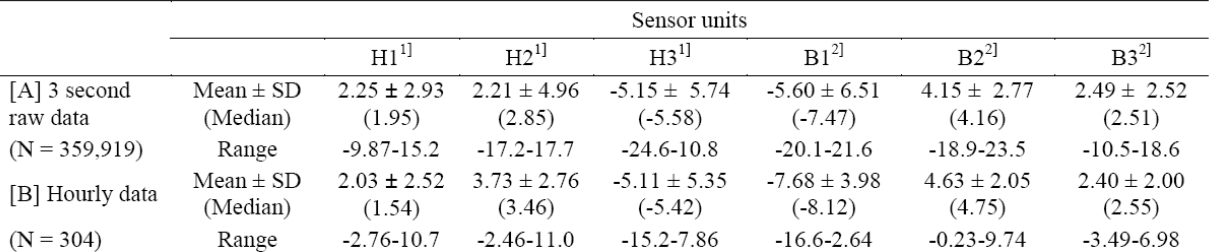
Table 3. A statistical summary of percent deviation (PD) values for each sensor unit calculated from the raw data and hourly mean values of all 6 sensor